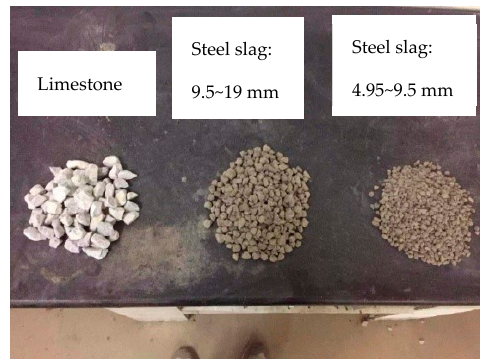
Figure 1. Aggregates of limestone and steel slag. Table 1. Physical and mechanical properties of steel slag and limestone.